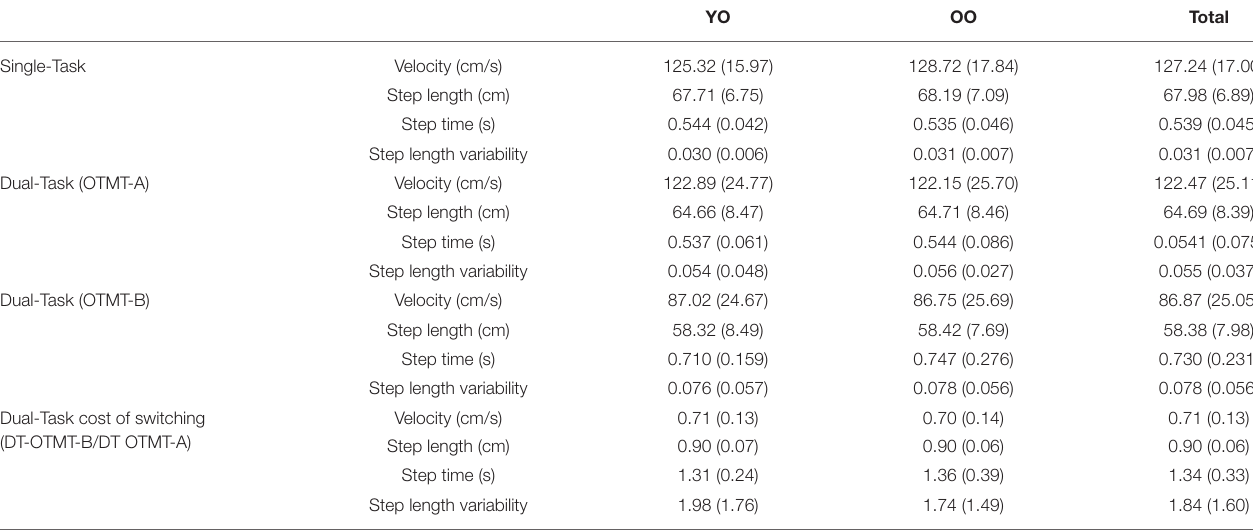
TABLE 2 | Gait parameters under single-task (ST) and dual-task (DT) conditions.